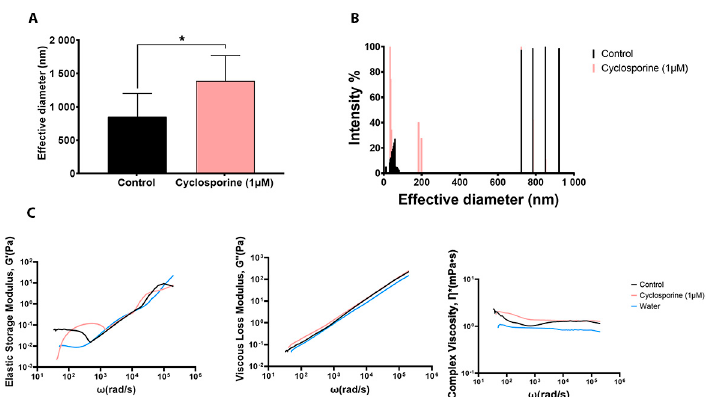
Figure 5. Calculation of the effective diameter ( A ) and size distribution ( B ) of PS secreted by C. neoformans in cells treated and not treated with 1µM of cyclosporine. * p -value = 0.0499. Statistical significance was determined using Student’s t test. ( C ) Passive microrheology of secreted polysaccharides (PS) from C. neoformans in the presence and absence of cyclosporine. Elastic modulus G ′ (Pa), left; viscous modulus G”(Pa), middle; and viscous complex Ƞ *(mPa•s), right, were measured.